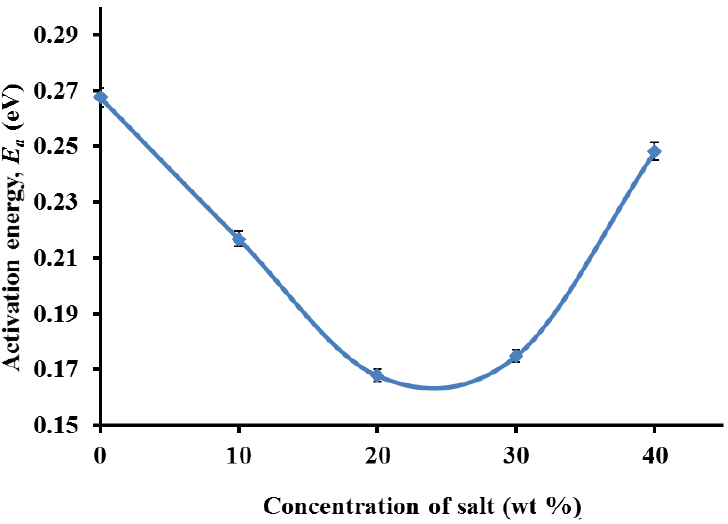
Figure 11. Activation energy vs. concentration of